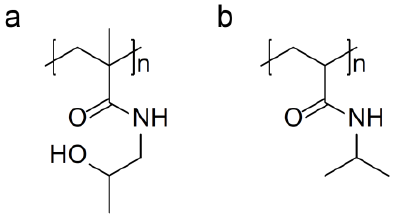
Figure 5. Chemical structure of commonly used thermos-responsive polymers: ( a ) poly(hydroxypropylmethacrylamide); and ( b ) poly( N -isopropylacrylaminde).